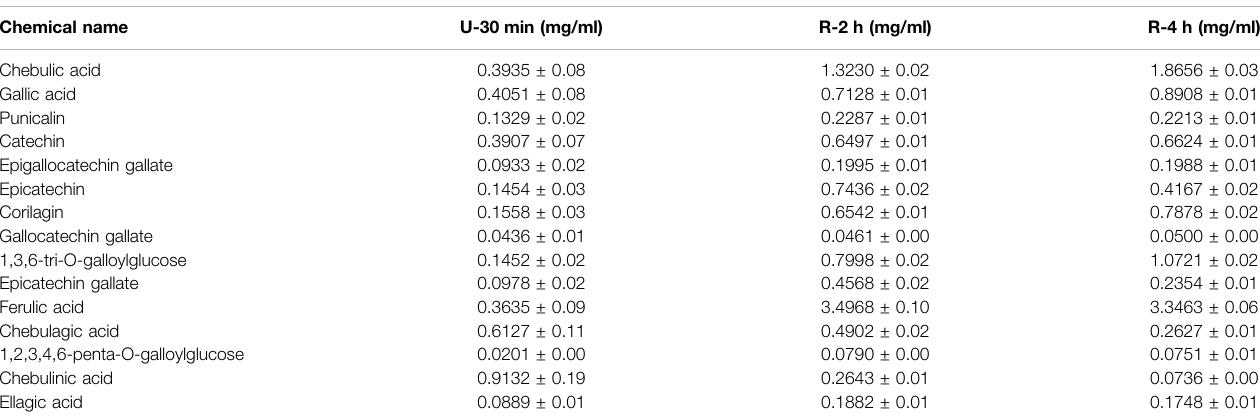
TABLE 2 | The variation of composition content in different decoction time ( x ± s, n (cid:1) 6). Chemical